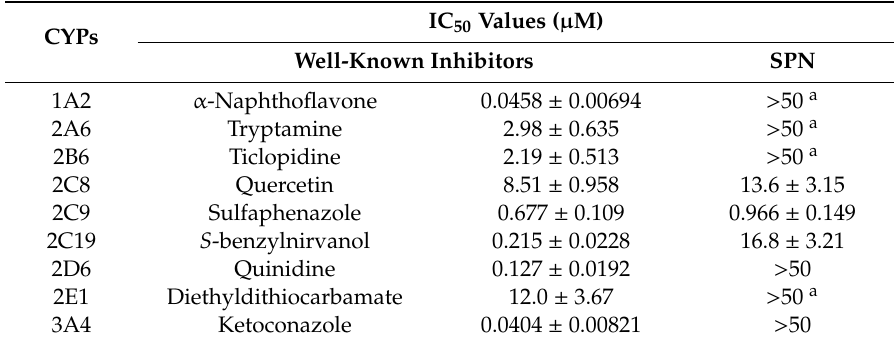
Table 2. IC 50 values of well-known CYP inhibitors and SPN in reversible inhibition studies using a cocktail assay ( n =